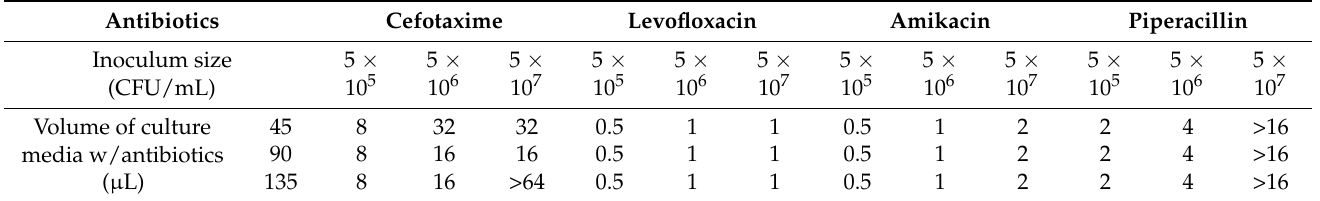
Table 2. MIC values of P. aeruginosa according to different bacterial inoculum sizes and volumes of culture media with antibiotics. The unit of MIC is µ